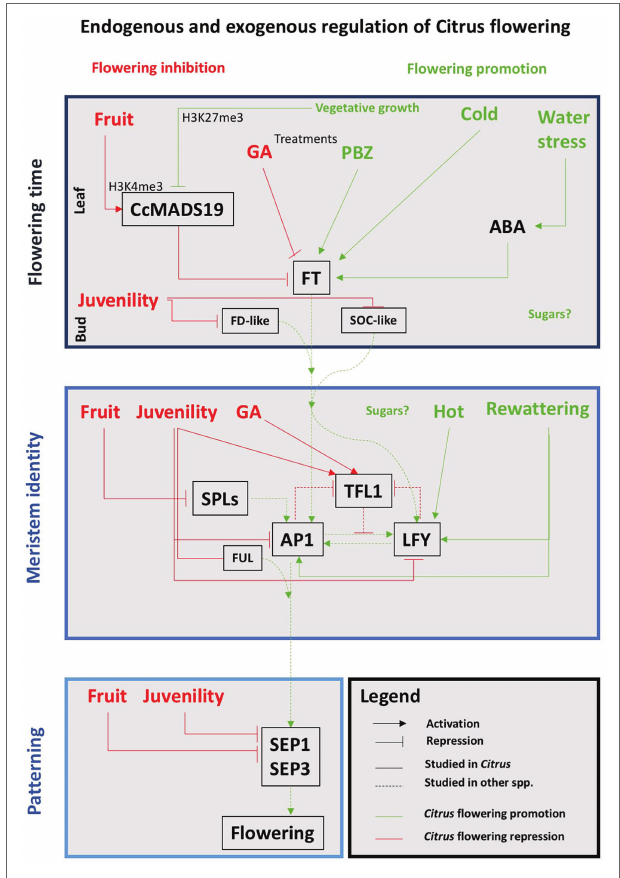
FIGURE 3 | Schematic representation of the correlations between endogenous and exogenous factors and the main genetic pathways involved in the floral transition in Citrus . Red and green words and lines indicate that the interaction results in flowering inhibition or promotion, respectively. See text for